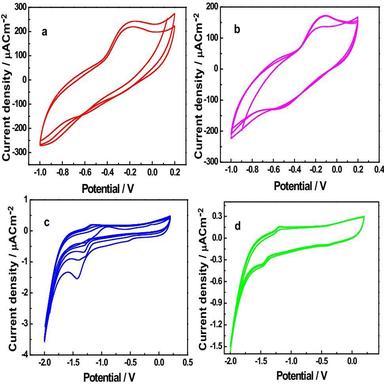
Cyclic Voltammetry analysis of DNA (a), DNA- GO@ZnO.TiO2.Ag (b), BSA(c) and BSA- GO@ZnO.TiO2.Ag (d).